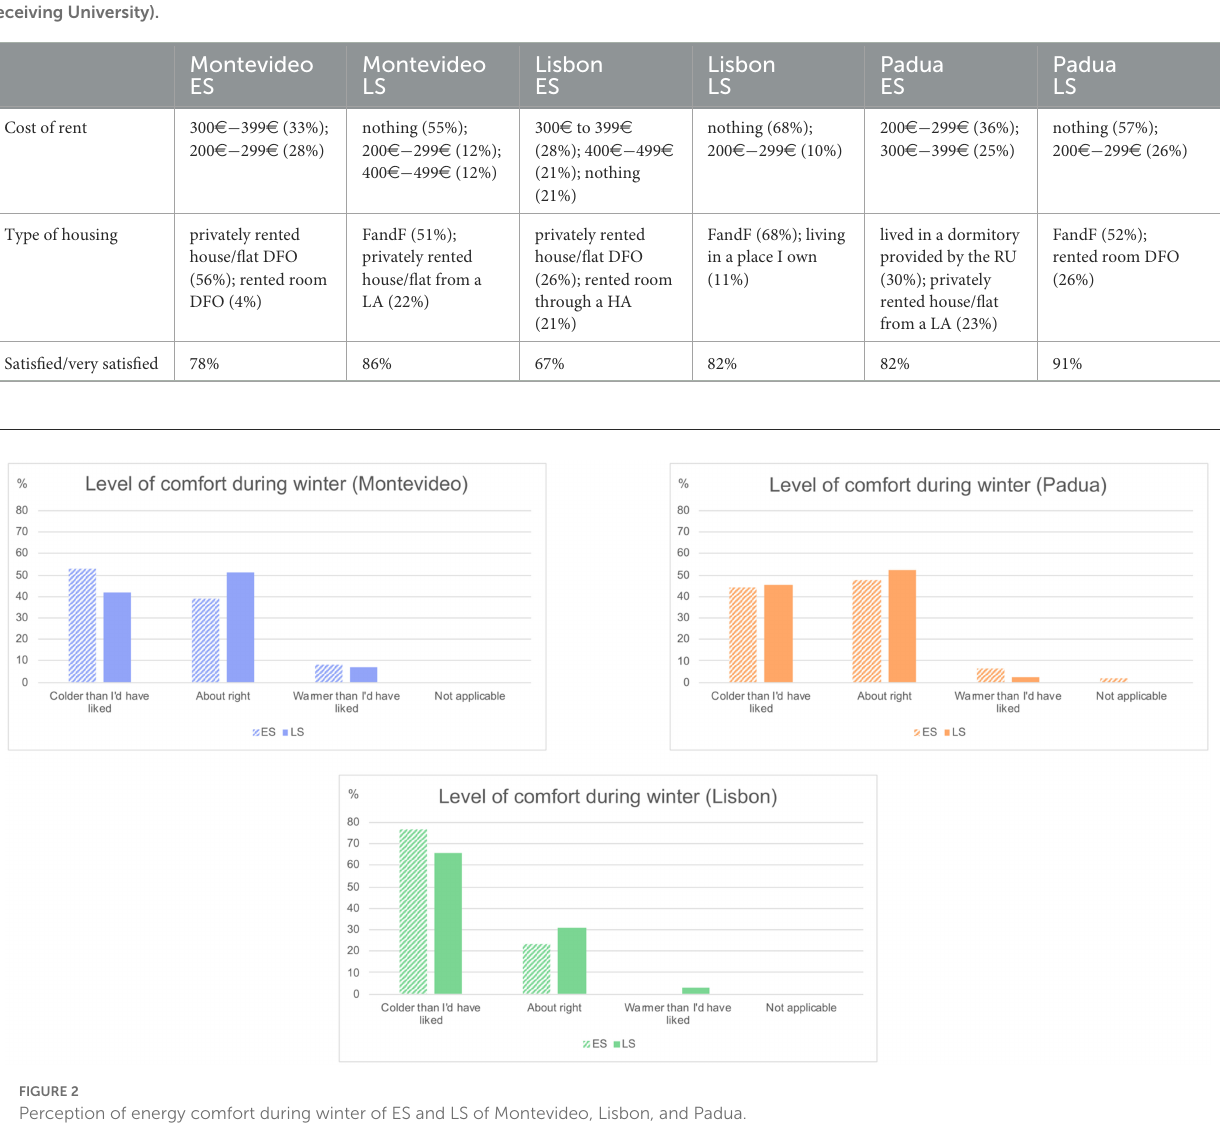
energy, more than 88% of all respondents from all the populations took action, and the most common action across all populations was, in fact, an adaptive strategy—“Wore more or less